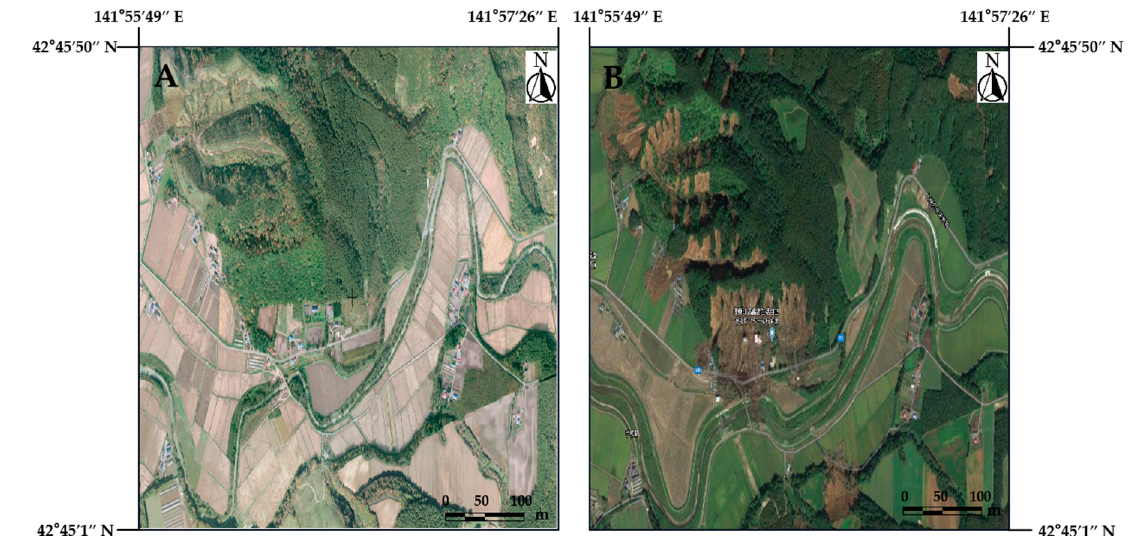
Figure 2. Landslide caused by the 2018 Hokkaido Eastern Iburi Earthquake in the Atsuma River basin (( A ) GSI: Geospatial Information Authority of Japan (2017) [26]; ( B ) Google Earth (2020) [31]).